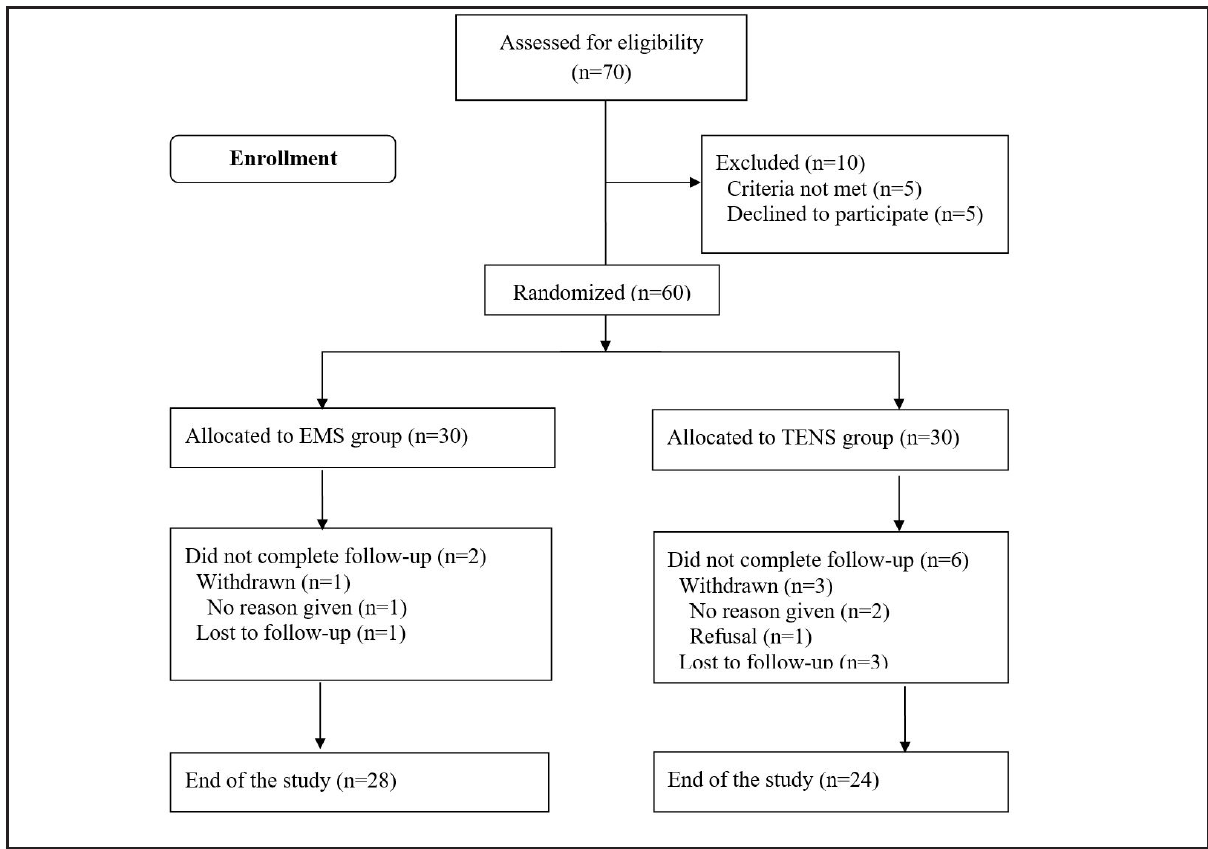
Figure 2. CONSORT Flowchart of participants’ progress during the